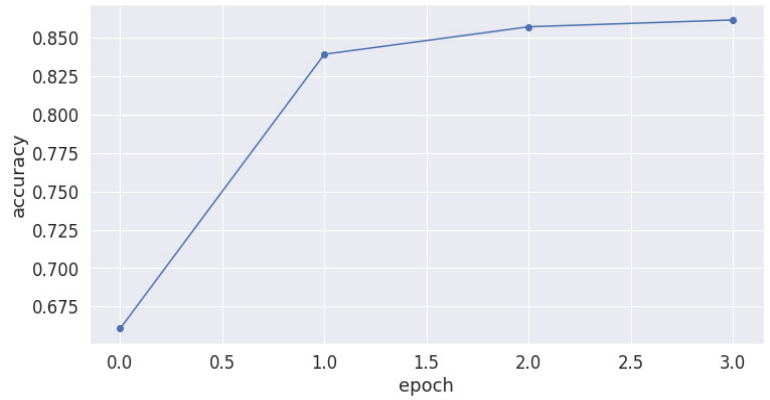
Figure 6. CovBERT model accuracy evolution over time with 4 epochs.